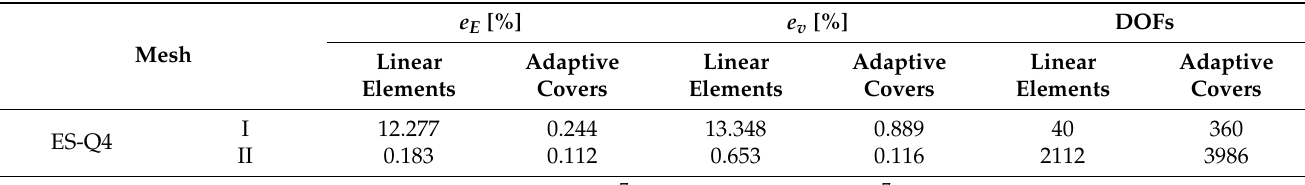
Table 1. Relative errors (%) in the energy norm ( E ) and the vertical displacement ( v ) at the point A in the Cook’s skew beam problem.